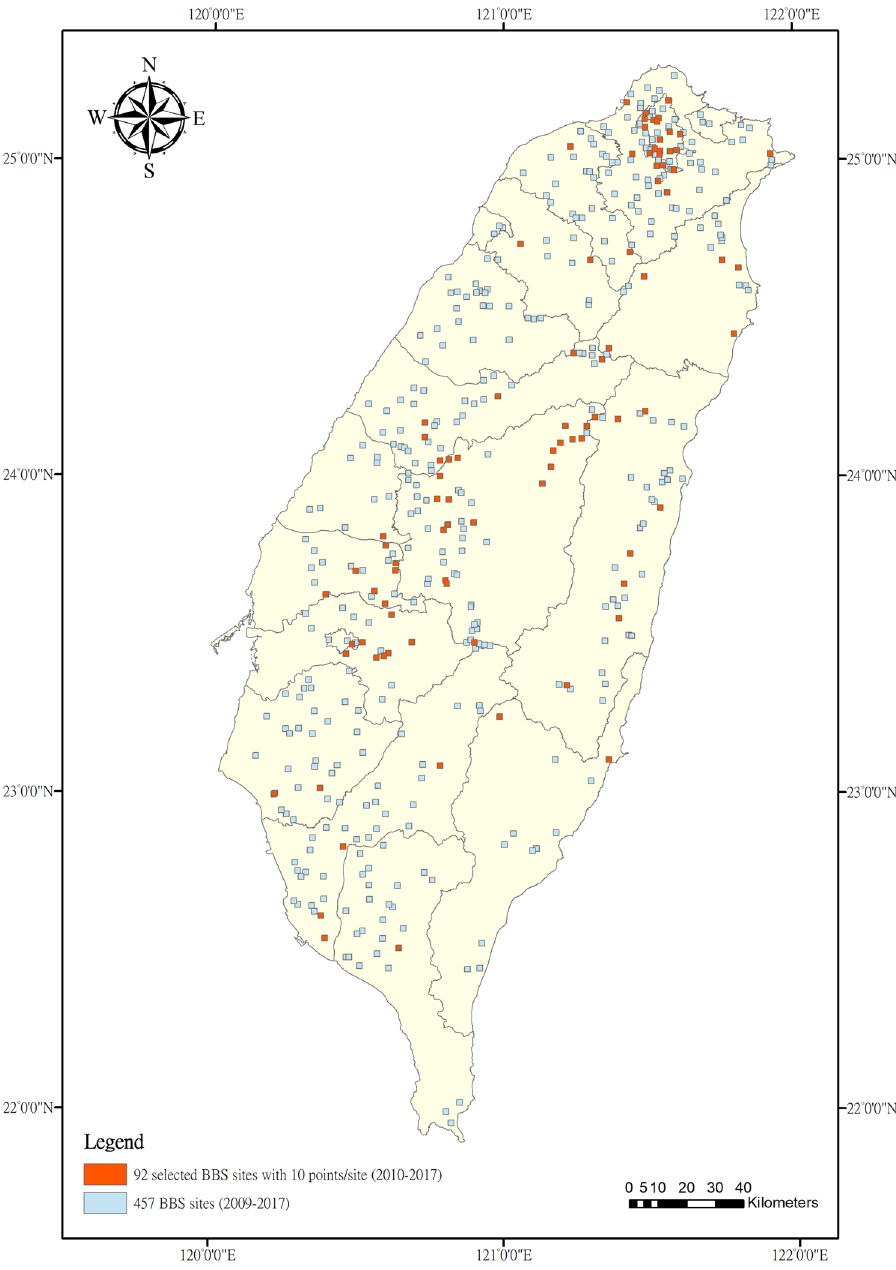
Figure 1. Distribution of selected 92 BBS sites (orange-colored) out of the original 457 BBS sites across Taiwan island. Solid black lines indicate the border of each county in Taiwan. Figure is drawn using ArcGIS 10.6. (http:// www. esri. com/ softw are/